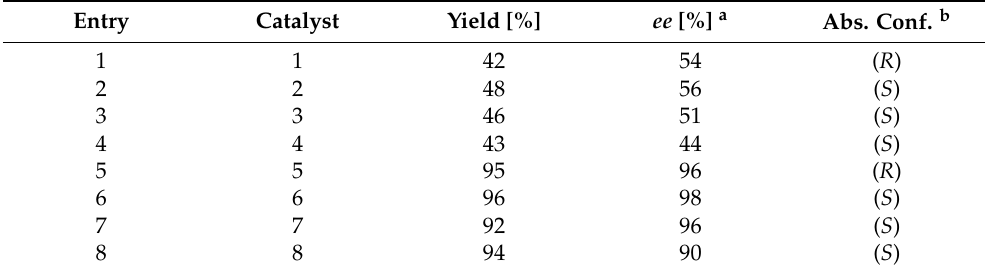
Table 1. Asymmetric Morita–Baylis–Hillman reaction catalyzed by aziridine-phosphines 1 – 8 .